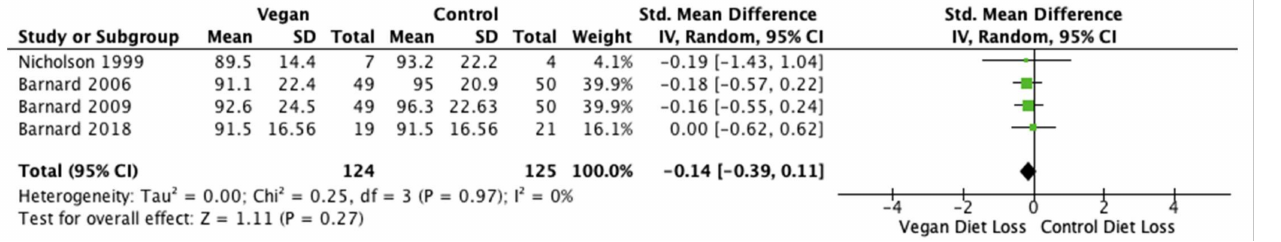
Figure 4. Forest plot comparing weight loss after consumption of low-fat vegan and control diets [28,40,41,47].